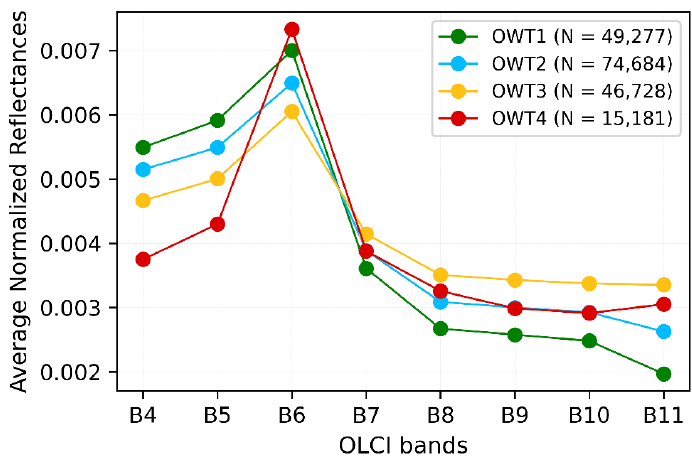
Figure 5. Average normalized reflectance spectra derived from the k-means classification by class (OWT1, OWT2, OWT3, and OWT4).